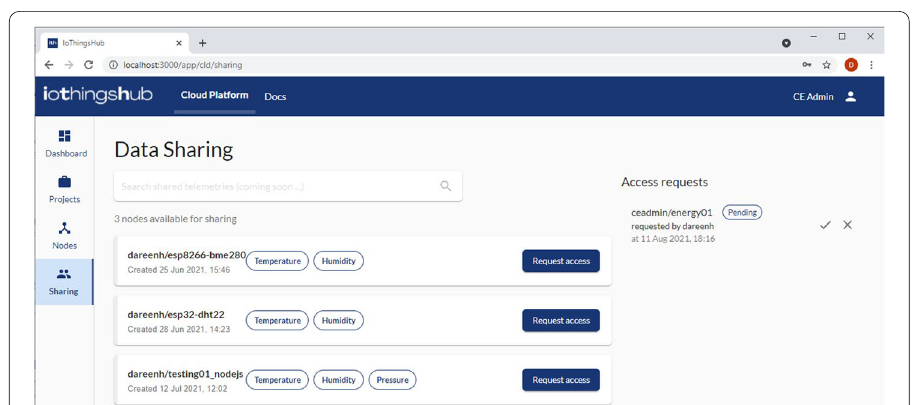
Fig. 15 IoThingsHub—an example of nodes sharing